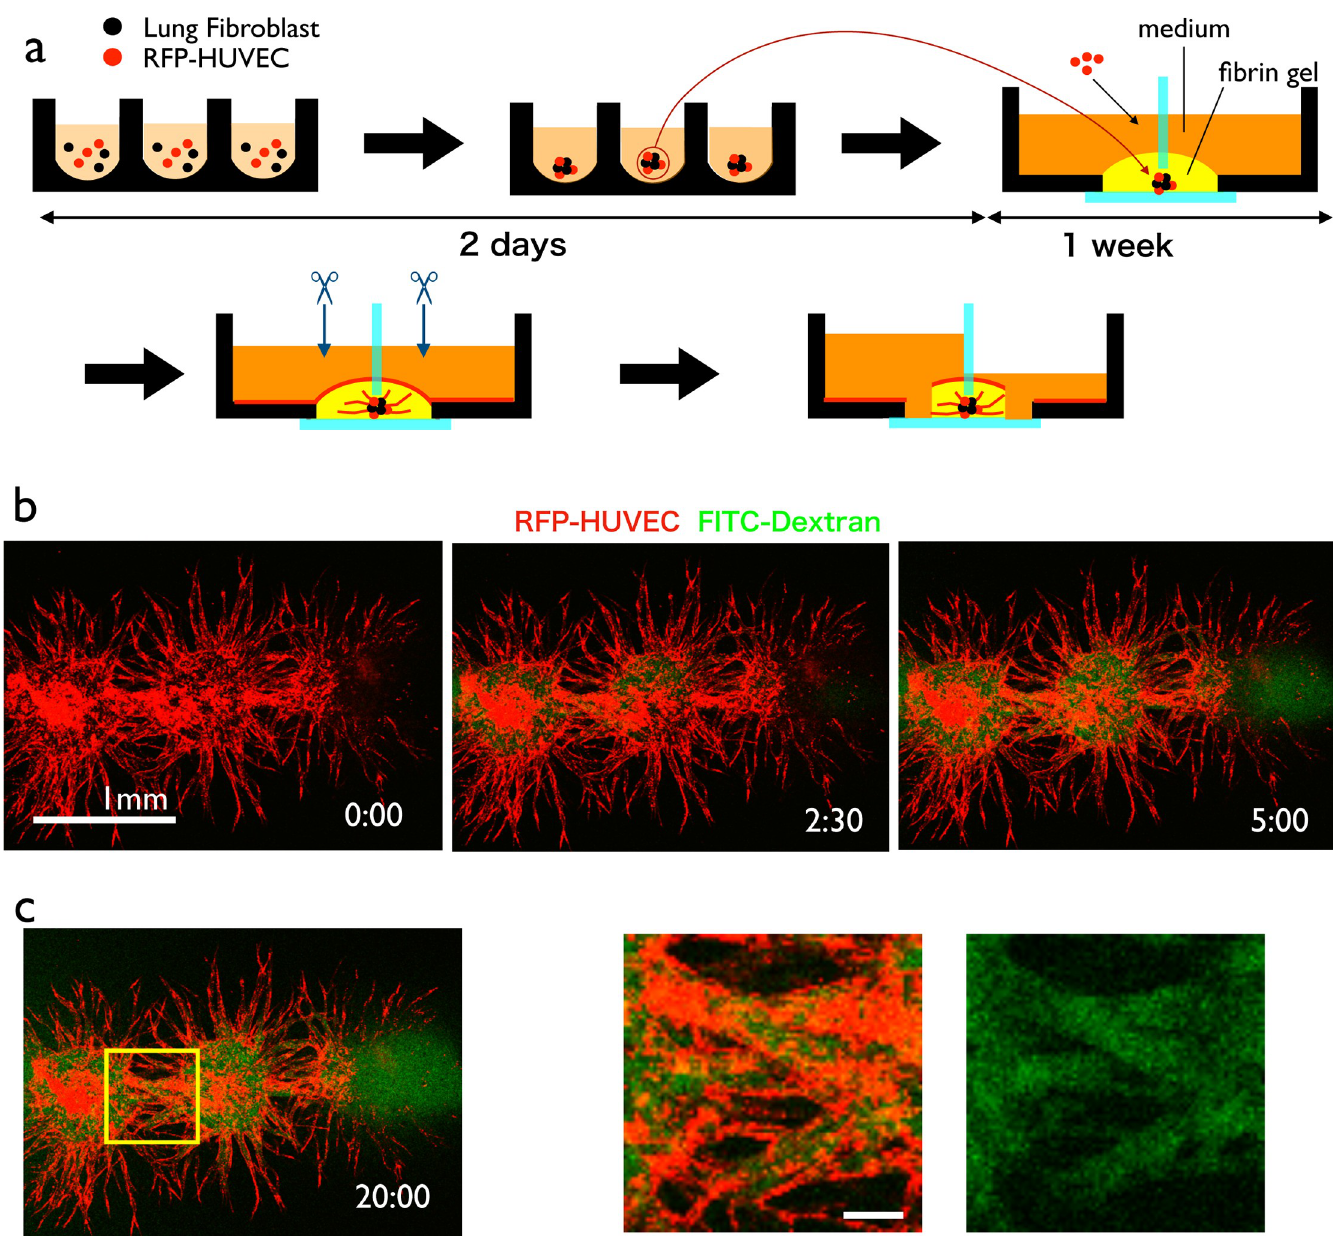
Fig 8. Perfusion of vascularized spheroids. (a) Experimental procedure. Spheroids containing RFP-HUVECs and lung fibroblast were generated and embedded in fibrin gel. After 1 week, sprouts from the spheroids became sufficiently long. Then, we cut the tip of the sprouts from both sides of the well and exerted static pressure to one side of the well. (b) Visualization of the perfusion inside the spheroid using FITC-dextran. (c) High-magnification view of the sprouts connecting two spheroids. FITC-dextran is running through the sprout structure. Scale bar: 1 mm (b); 100 μ m (c).